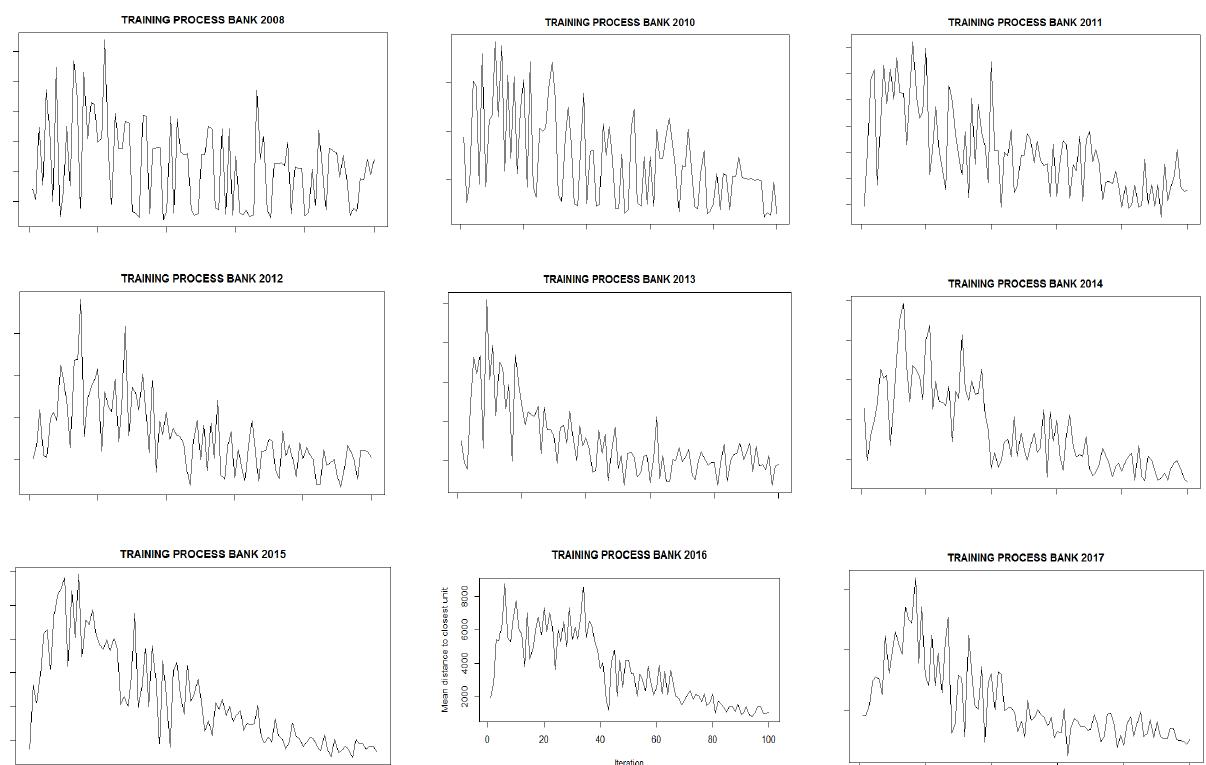
Figure A1. The SOM training process. Note: these figures represent mean distance to closest unit value during the training process (2008–2017). Source: author’s computation.